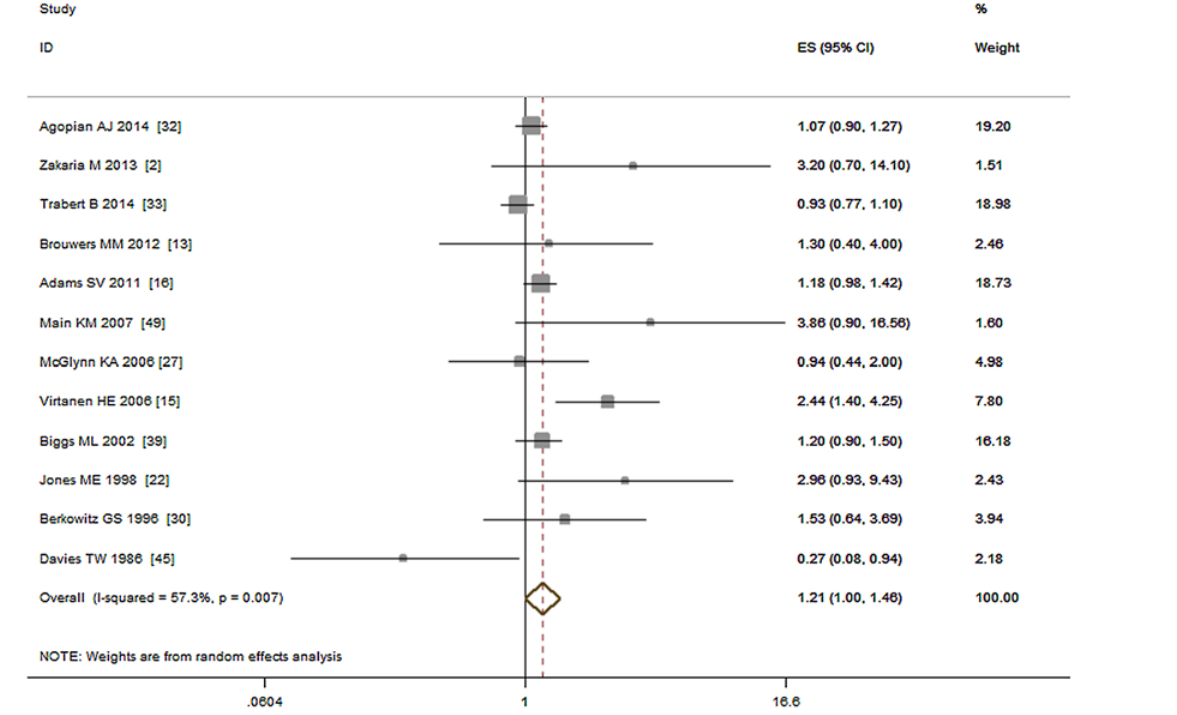
Fig 3. Forest plot for maternal gestational diabetes and risk of